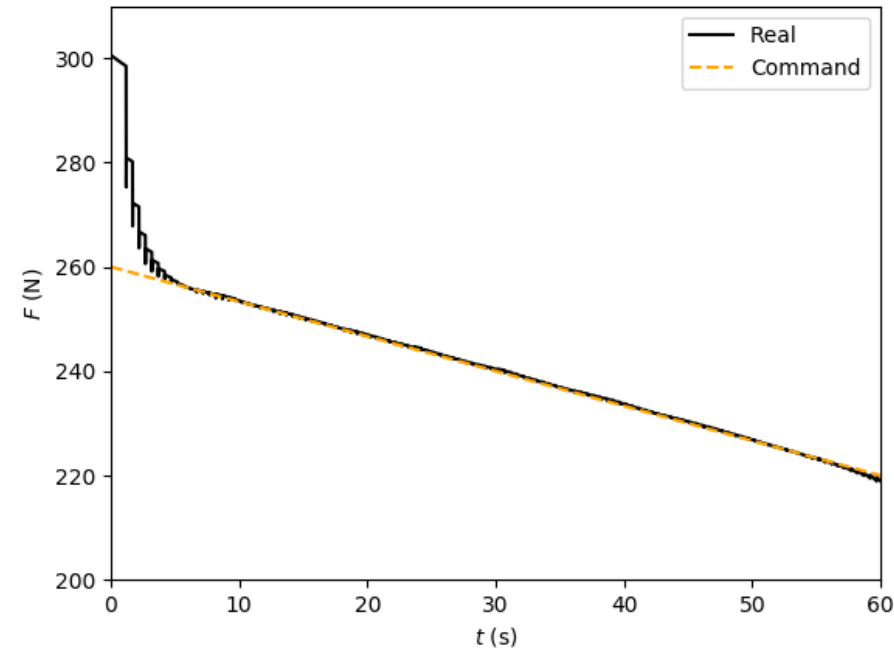
Figure 29. Thrust profile, feedback with complete regulation law, case